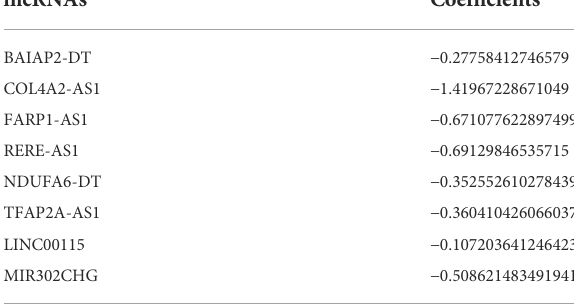
TABLE 3 m7G-lncRNAs selected to build m7G-LPS and the corresponding coef fi cients.